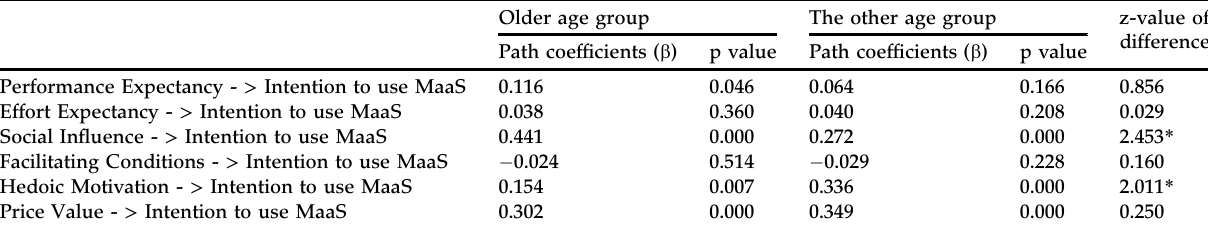
Table 5. The results of multigroup